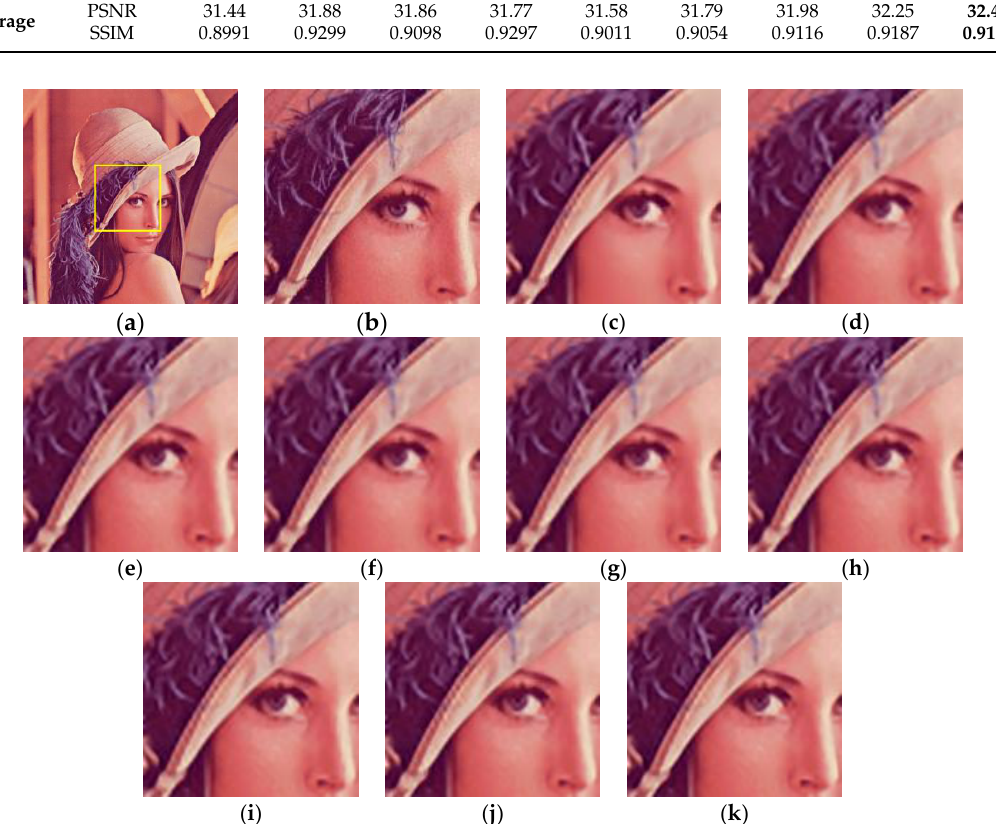
Figure 7. Comparison of the reconstructed images with different SR algorithms for Lena . L1SR: Super Resolution with L1 Regression; SISR: Single Image Super Resolution; ANR: Anchored Neighborhood Regression; NE + LS: Neighbor Embedding with Least Squares; NE + NNLS: Neighbor Embedding with Non-Negative Least Square; NE + LLE: Neighbor Embedding with Locally Linear Embedding; A + (16 atoms): Adjusted Anchored Neighborhood Regression; ISPSR: improved Super Resolution based on Sparse representation; SRISAE: SR algorithm based on the ISAE. ( a ) Lena; ( b ) Reference; ( c ) L1SR; ( d ) SISR; ( e ) ANR; ( f ) NE + LS; ( g ) NE + NNLS; ( h ) NE + LLE; ( i ) A + (16 atoms); ( j ) ISPSR; ( k ) SRISAE.